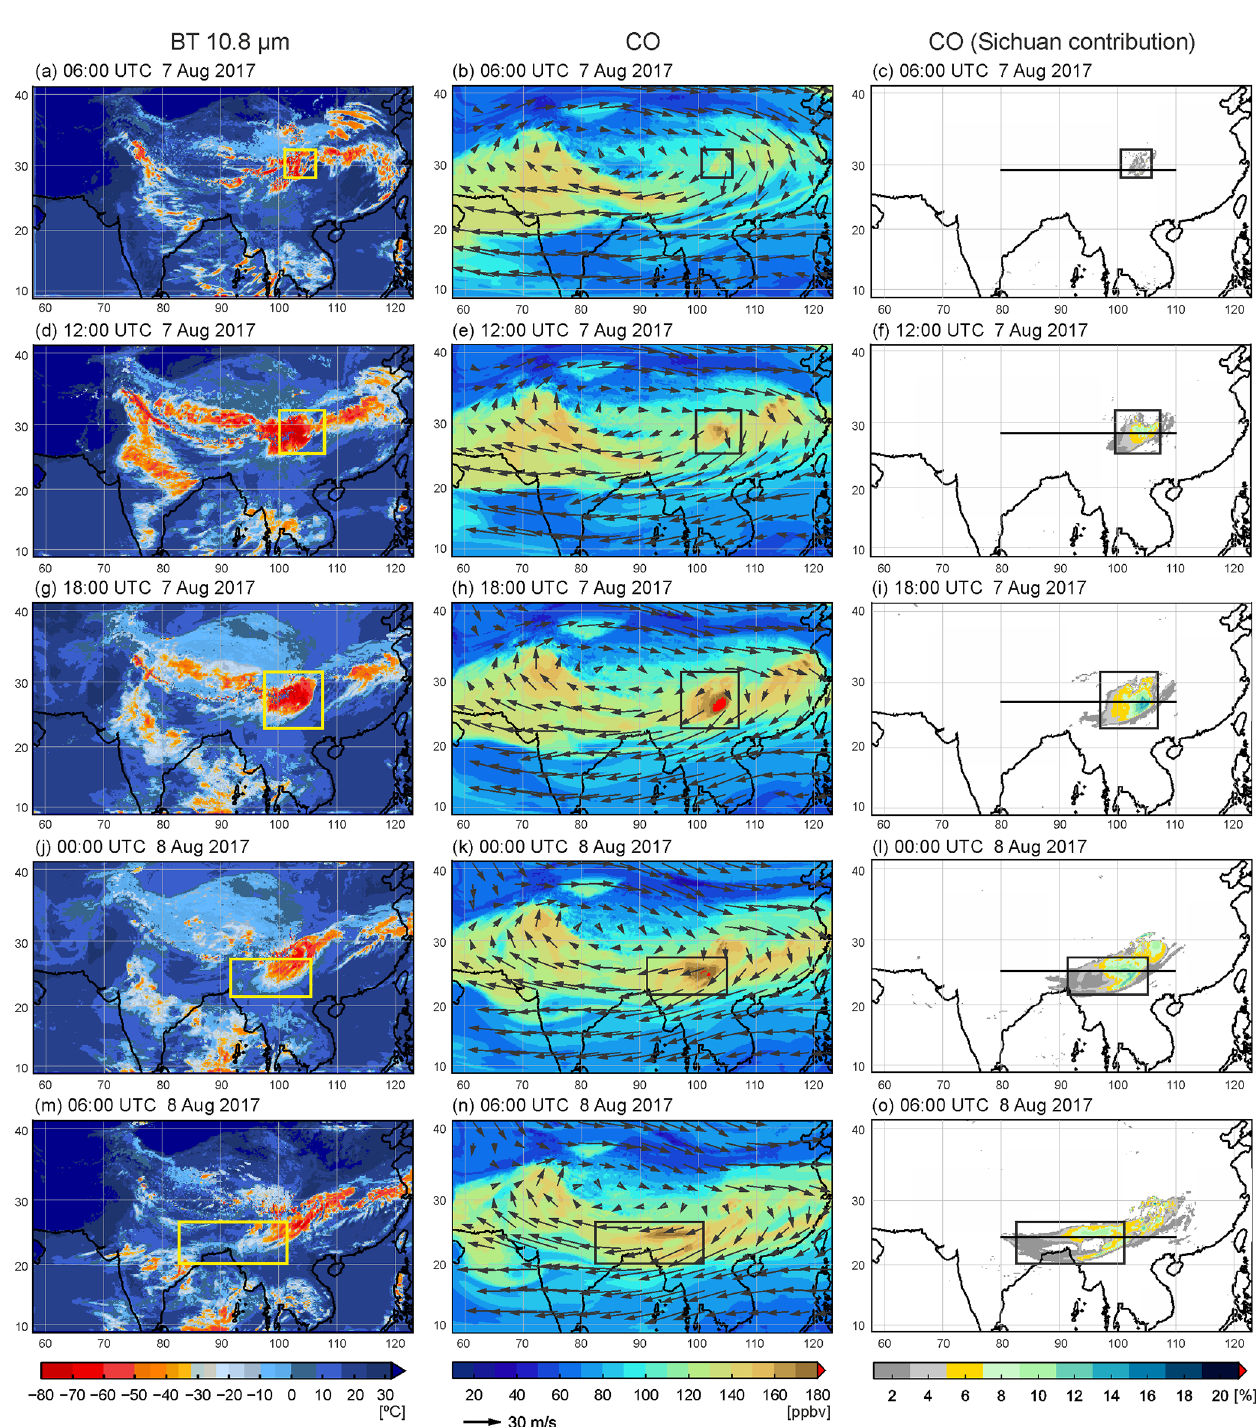
Figure 7. Horizontal map of simulated BT 10.8µm (K, a , d , g , j , m ), CO concentration (ppbv, b , e , h , k , n ), and CO concentration contributed by Sichuan emission (%, c , f , i , l , o ) at the altitude of 14.8km at (a–c) 06:00UTC, (d–f) 12:00UTC, (g–i) 18:00UTC on 7 August, (j–l) 00:00UTC, and (m–o) 06:00UTC on 8 August 2017. The area of interest is marked by a black or yellow (for visibility) box. In (c) , (f) , (i) , (l) , and (o) , the location of the longitude–altitude cross section used in Fig. 8 is marked by a black solid line.